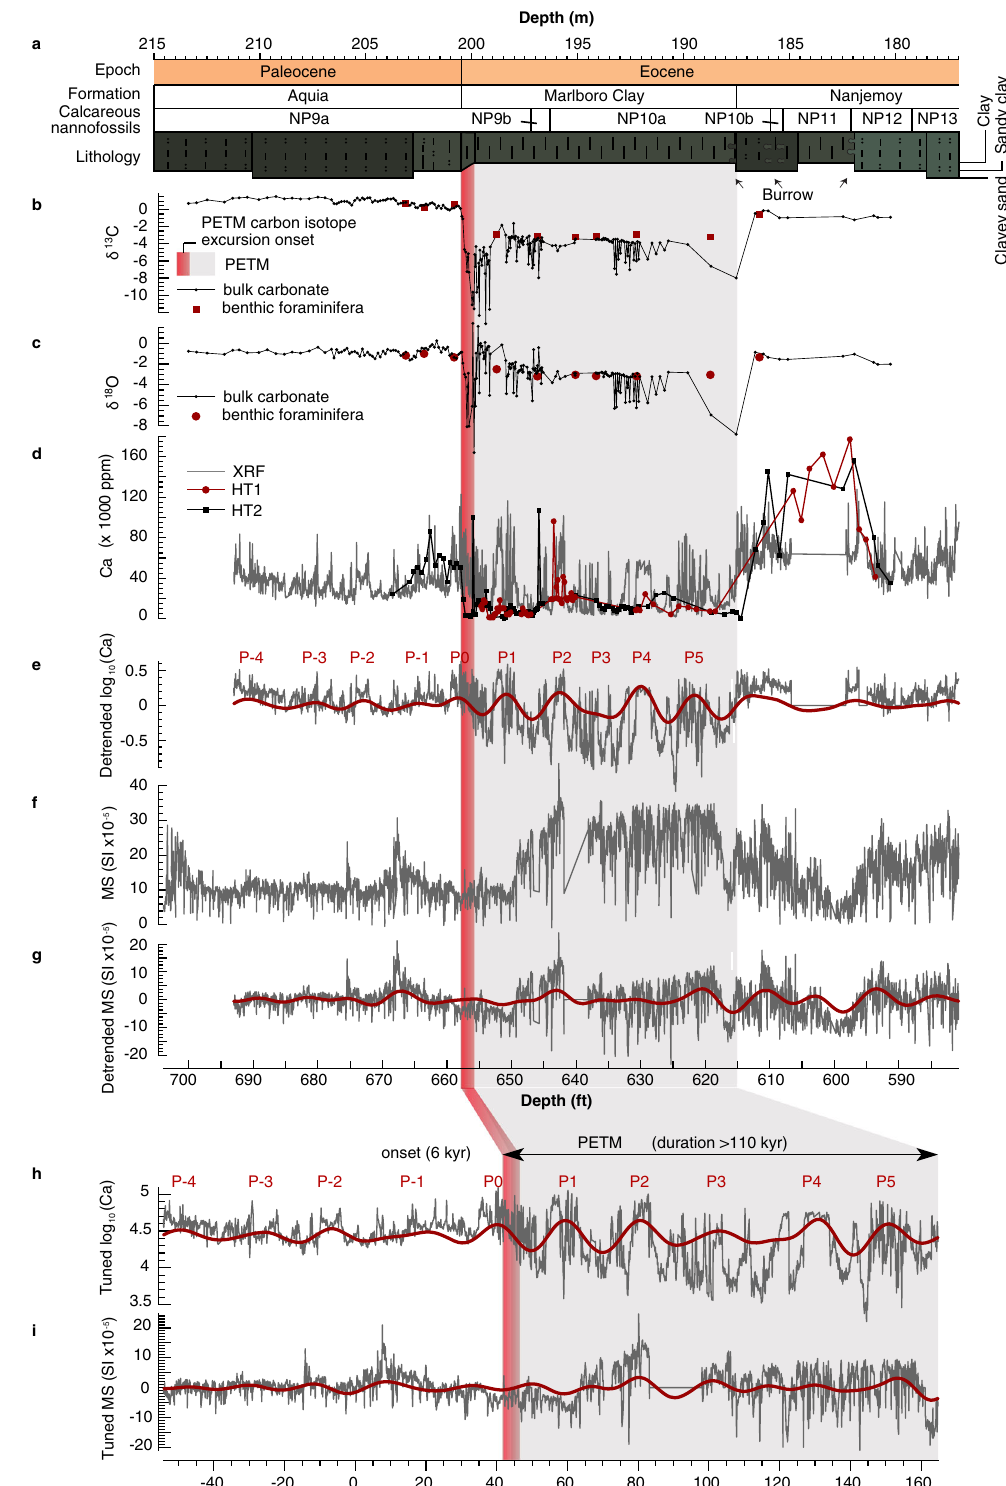
Fig. 2 | Time series analyses. a Chronostratigraphy, lithostratigraphy, calcareous nannofossil zones, and lithology for the Howards Tract (HT) cores. The schematic core log shows the grain size and sediment color of the cores. b δ 13 C of the HT cores. c δ 18 OoftheHTcores. d CalciumcontentgeneratedfromX-ray fl uorescence (XRF) scans of the HT cores correlates well with carbonate content from both Howards Tract 1 (HT1) and Howards Tract 2 (HT2). Ca data from 182 – 185m is missing due to a coring gap. e Filtered 2.8m cycles indicative of precession (P)